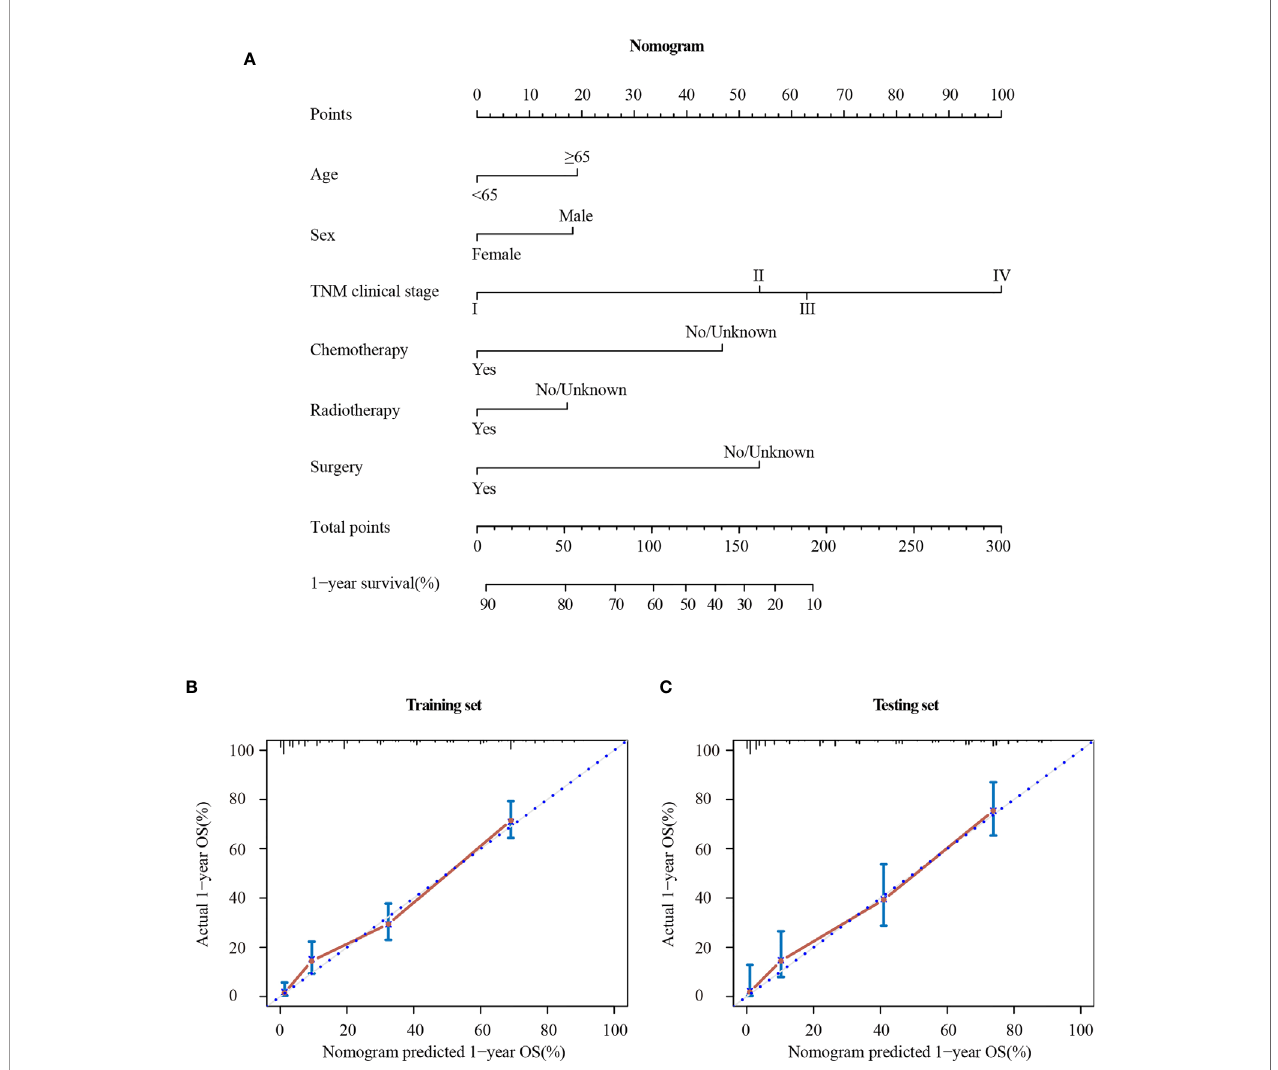
FIGURE 6 | Nomogram (A) and calibration curve in the training set (B) and testing set (C) . TNM clinical stage, tumor – node – metastasis clinical